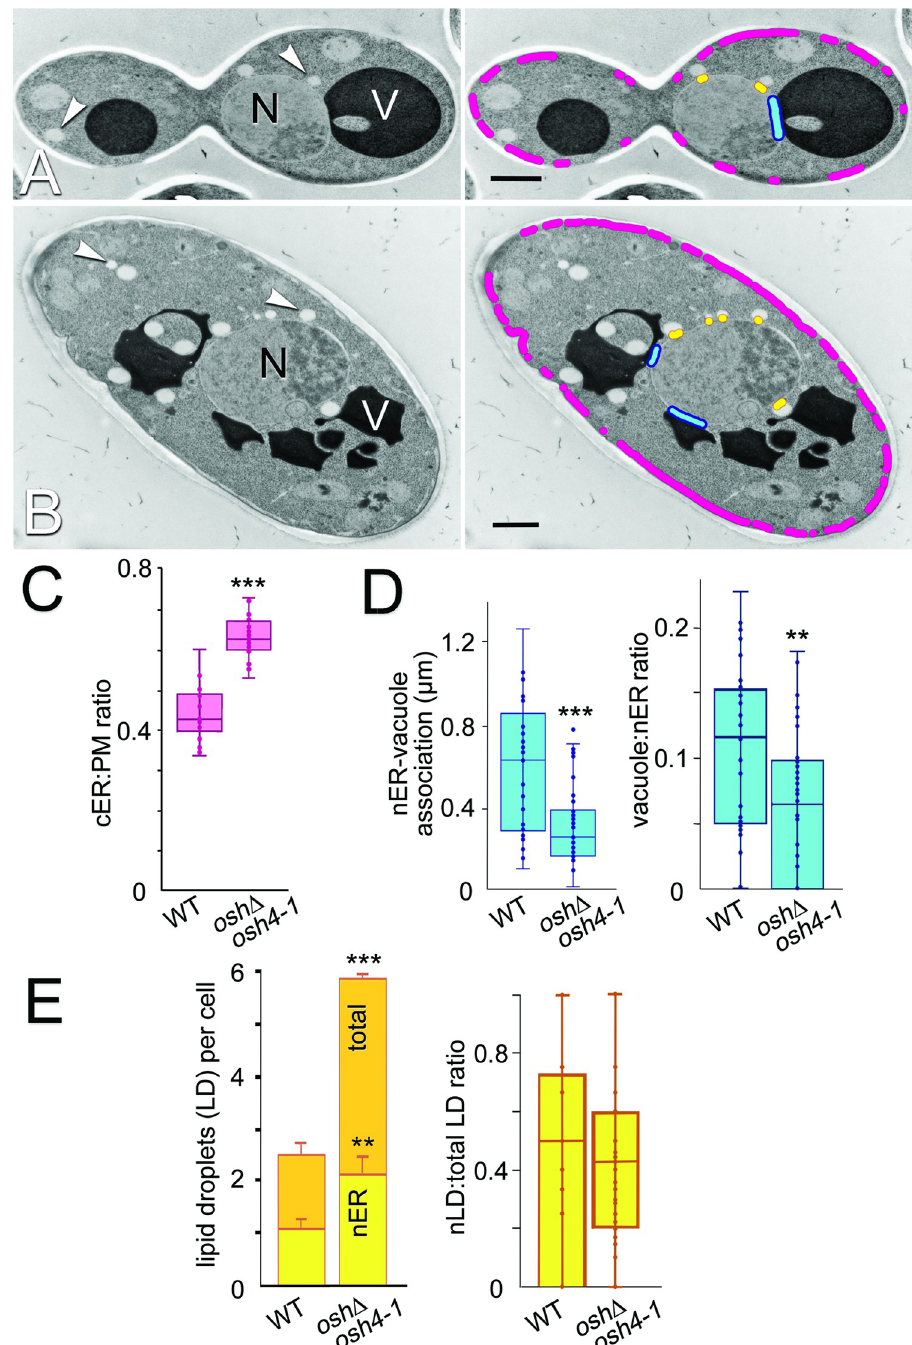
Fig 1. Effect of eliminating all Osh proteins on cortical ER-PM contact, nuclear ER-vacuole and nuclear ER-lipid droplet association. (A) Transmission electron micrographs of WT (SEY6210) and ( B) osh4-1 ts osh Δ (CBY926) cells at 37˚C for 1 h. Right panels highlight cortical ER association with the PM (magenta), nuclear ER association with vacuoles (blue), and nuclear ER association with lipid droplets (yellow). N, nucleus;V, vacuole, arrowheads indicate examples of lipid droplets. ( C) Quantification of WT and osh4-1 ts osh Δ cell electron micrographs of the ratio of total lengths of cortical associated ER (cER) relative to the total PM lengths in WT and osh4-1 ts osh Δ cells (n = 25 cells for each strain). ( D) Left: quantification of the average length ( μ m) of nuclear ER (nER) in association with vacuolar membrane in WT and osh4-1 ts osh Δ cells (n � 29 cells). Right: ratio of nER associated with vacuolar membrane per the total nER (n � 31 cells). ( E) Left: comparison of total numbers of lipid droplets (LD) per cell (orange) and the